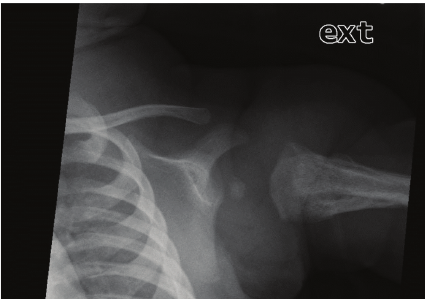
Figure 4: AP view of the left shoulder demonstrates abundant new bone along the left humeral shaft compatible with healing and ossification of the epiphysis within the glenoid